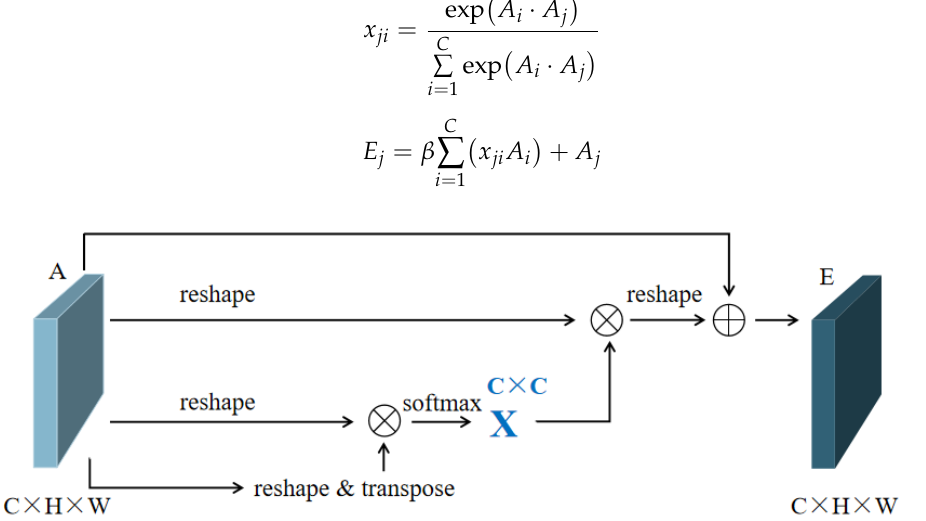
Figure 4. The structure of the channel attention module.